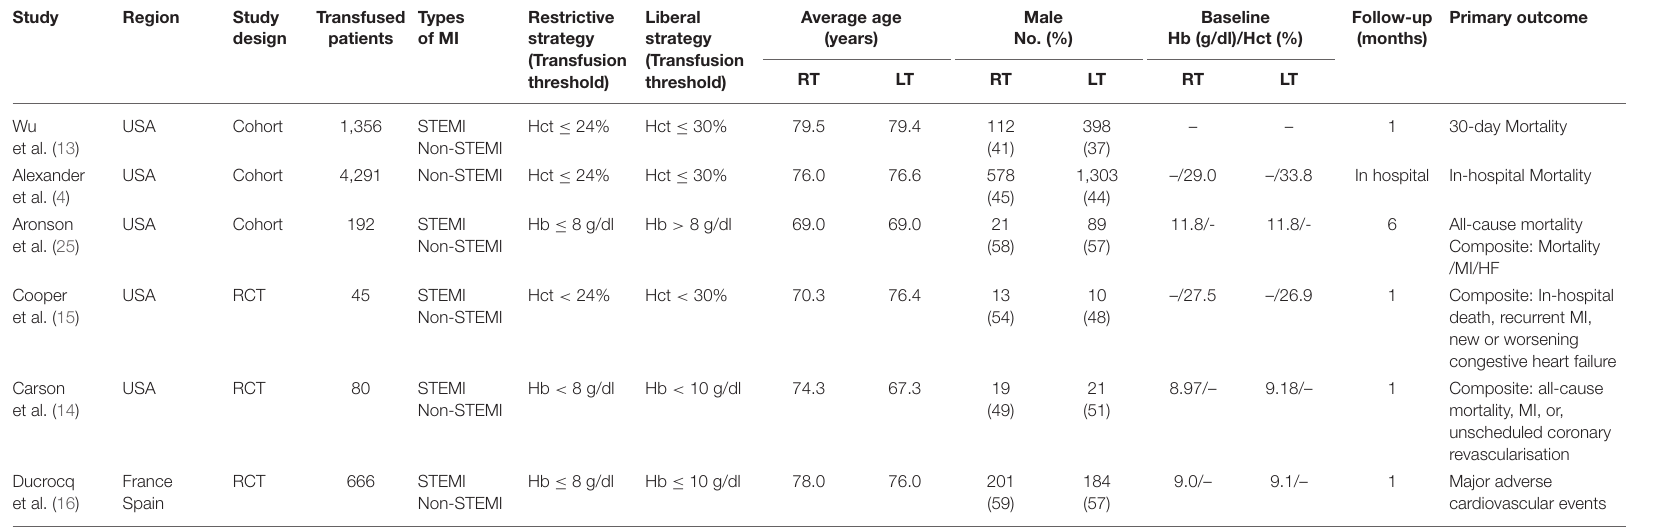
TABLE 1 | Characteristics of included studies in this meta-analysis.